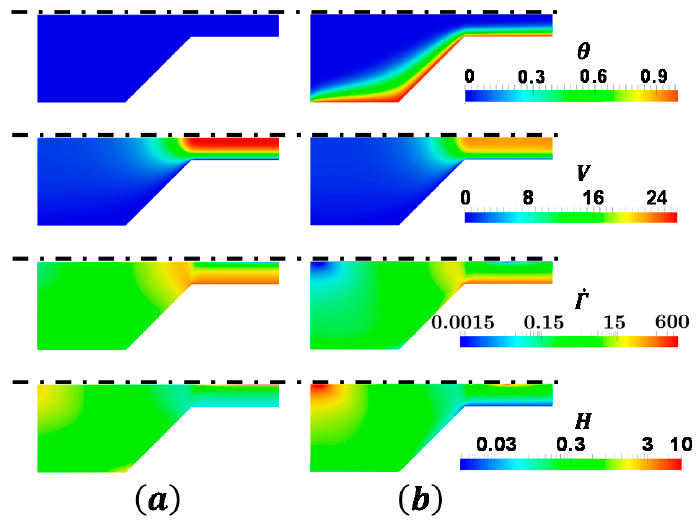
Figure 6. Contours of dimensionless temperature, velocity, shear rate and apparent viscosity of ( a ) non-heating walls and ( b ) heated walls. The dimensionless temperature of the inlet and the hot wall are 0 and 1, respectively. Re gen = 2.3 × 10 − 2 .